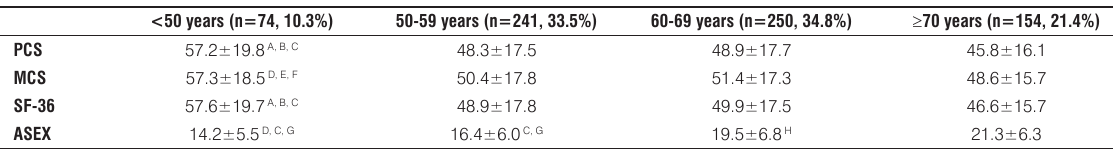
Table 4. HRQoL and ASEX in relation to